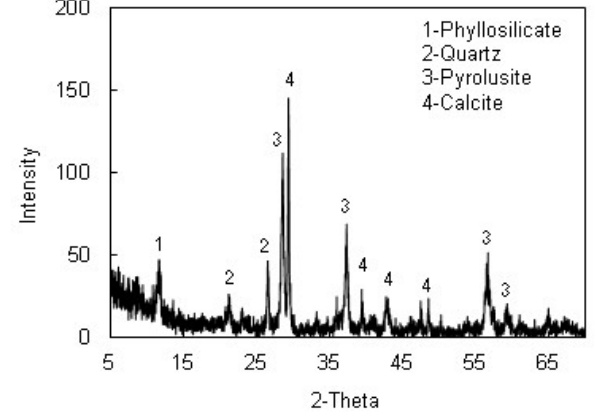
Fig. 1. X ray diffraction pattern of the ore sample used in the